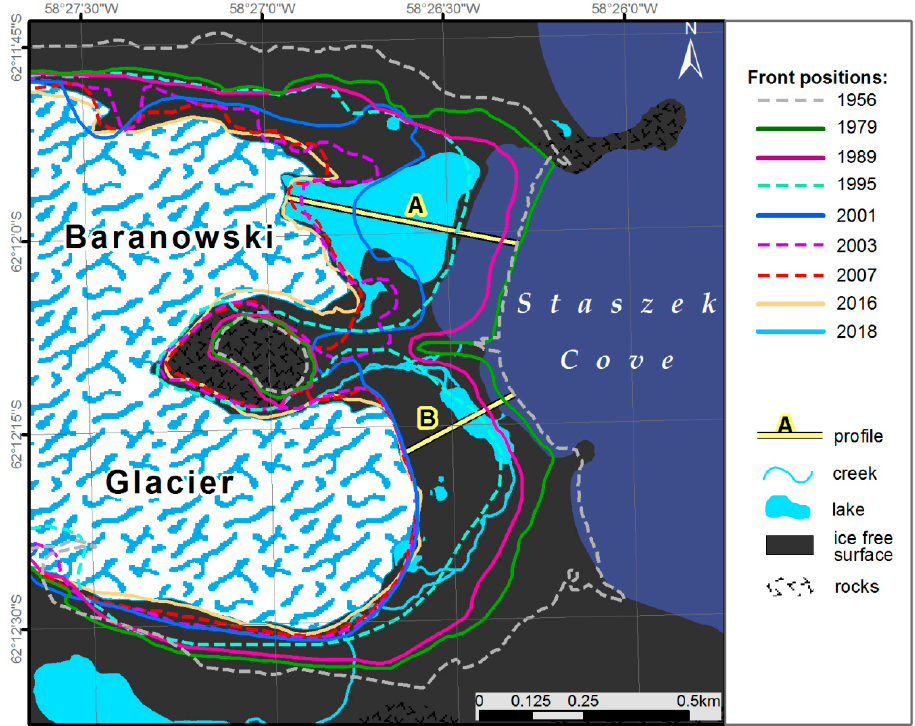
Figure 3. Front position changes based on aerial (1956, 1979) and satellite (1995, 2003, 2007, 2018) images, archival maps (1989, 2001), and terrestrial laser scanner (TLS) survey (2016). Reference system: WGS 1984, UTM zone 21S, geoid EGM96. Base map is Landsat acquired on 05 February 2018.